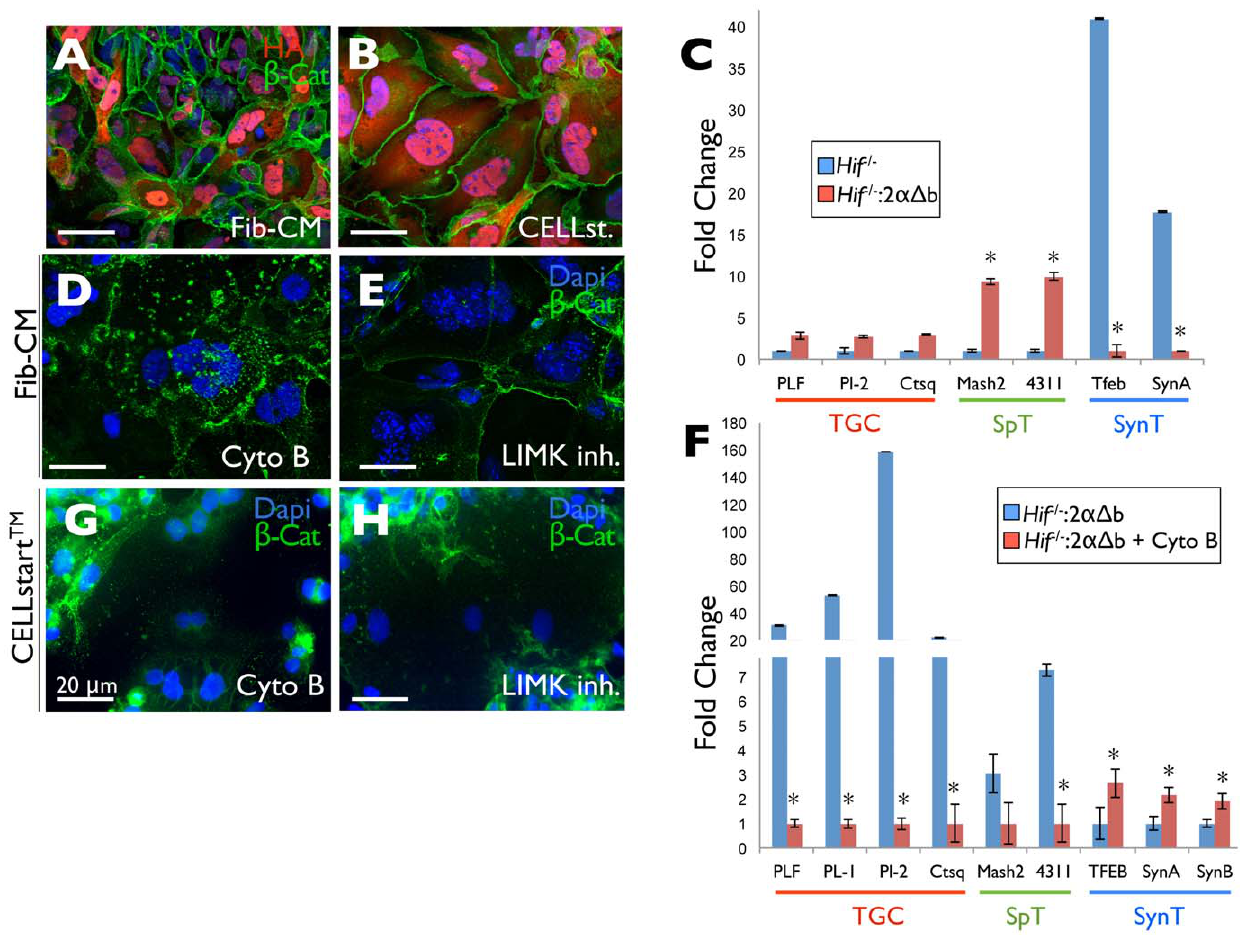
Figure 8. Non-canonical HIF-2-dependent LIMK1 expression promotes TGC formation. Immunofluorescence microscopy of HIF-2 aD b expressing Hif-1/2 a 2 / 2 TSCs differentiated following culture on TC plastic in Fib-CM (A) or on CELLstart TM (B) (green= b -Cat, red=HA). (C) qRT-PCR- based comparison of expression levels of the TGC (PLF, Pl-2, Ctsq), spongiotrophoblast (Mash2, 4311) and SynT (Tfeb, SynA) markers in Hif-1/2 a 2 / 2 and HIF-2 aD b reconstituted HIF-null ( Hif 2 / 2 :2 aD b) TSCs differentiated for 7 days following culture on TC plastic in Fib-CM. p values , 0.05 versus HIF- null indicated by an asterisk. (D) Immunofluorescence microscopy of HIF-2 aD b expressing Hif-1/2 a 2 / 2 TSCs differentiated following culture on TC plastic in Fib-CM in the presence of Cytochalasin B or (E) the LIMK inhibitor (BMS-5 10 uM)(green= b -Cat). (F) qRT-PCR-based comparison of expression levels of the TGC (PLF, Pl-1, Pl-2, Ctsq), spongiotrophoblast (Mash2, 4311) and SynT (Tfeb, SynA) markers in HIF-2 aD b reconstituted HIF- null ( Hif 2 / 2 :2 aD b) TSCs differentiated for 7 days following culture on TC plastic in Fib-CM without and with the actin cytoskeleton disrupting agent cytochalasin B (Cyto B). p values , 0.05 versus drug free control indicated by an asterisk. (G) Immunofluorescence microscopy of HIF-2 aD b expressing Hif-1/2 a 2 / 2 TSCs differentiated following culture on CellStart TM in the presence of Cytochalasin B or (H) the LIMK inhibitor (BMS-5 10 uM)(green= b - Cat).